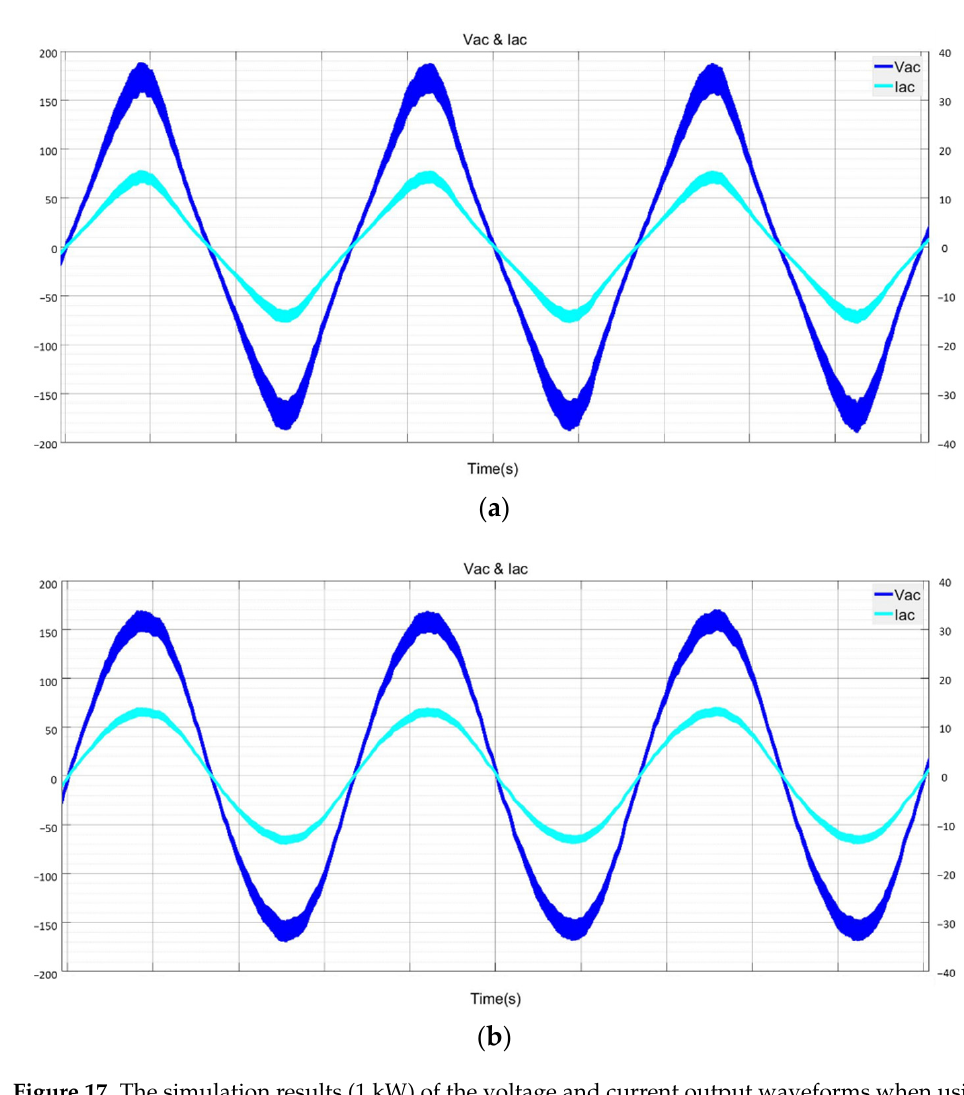
Figure 17. The simulation results (1 kW) of the voltage and current output waveforms when using ( a ) the traditional SPWM control and ( b ) modified SPWM control.